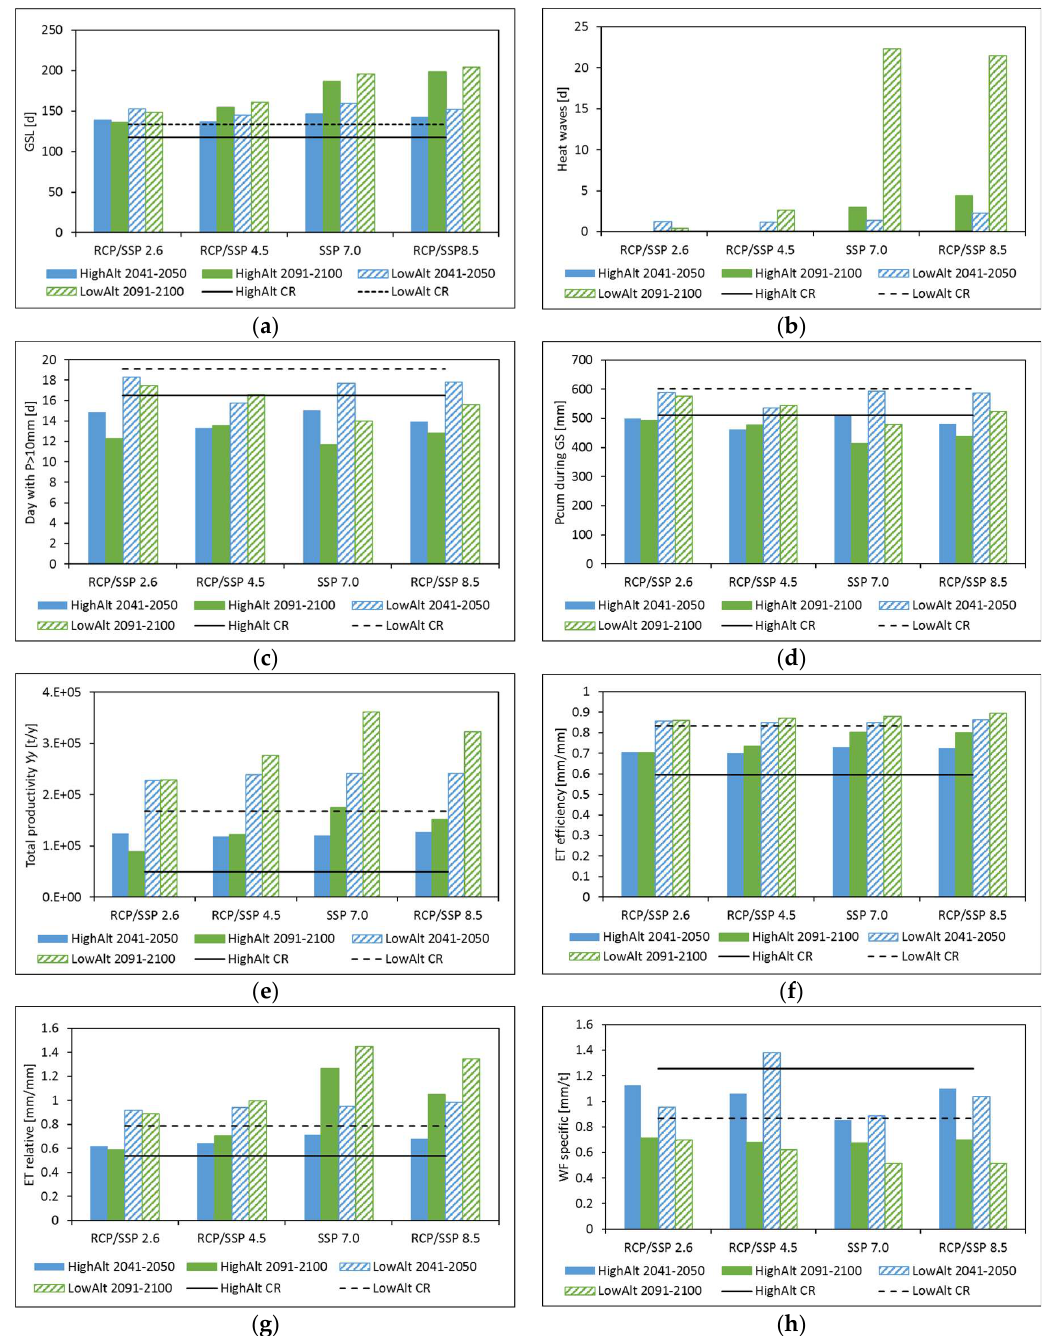
Figure 7. Future projections of agroclimatic indices (AIs) with respect to the control run (CR) period for two pasture species: ( a ) growth season length (GSL) (AI1), ( b ) heat waves frequency (AI2), ( c ) number of days with P larger than 10 mm (AI3), ( d ) cumulated P during GS (AI4), ( e ) productivity Yy (AI5), ( f ) evapotranspiration (ET) efficiency (AI6), ( g ) relative evapotranspiration (ET) (AI7), ( h ) specific water footprint (WF) (AI8). The reported values are the average with respect to the scenario (RCP/SSP 2.6; RCP/SSP 4.5; SSP 7.0; RCP/SSP 8.5) of all the GCMs. Values at the middle of the century (2041–2050) are reported in blue, while values at the end of the century (2091–2100) are in green. Values for Nardus stricta are reported in plain color (HighAlt, >2000 m asl), and values of Trisetum flavescens are reported with lines (LowAlt, <2000 m asl). Black lines refer to the present values (dotted for LowAlt and continuum for HighAlt).